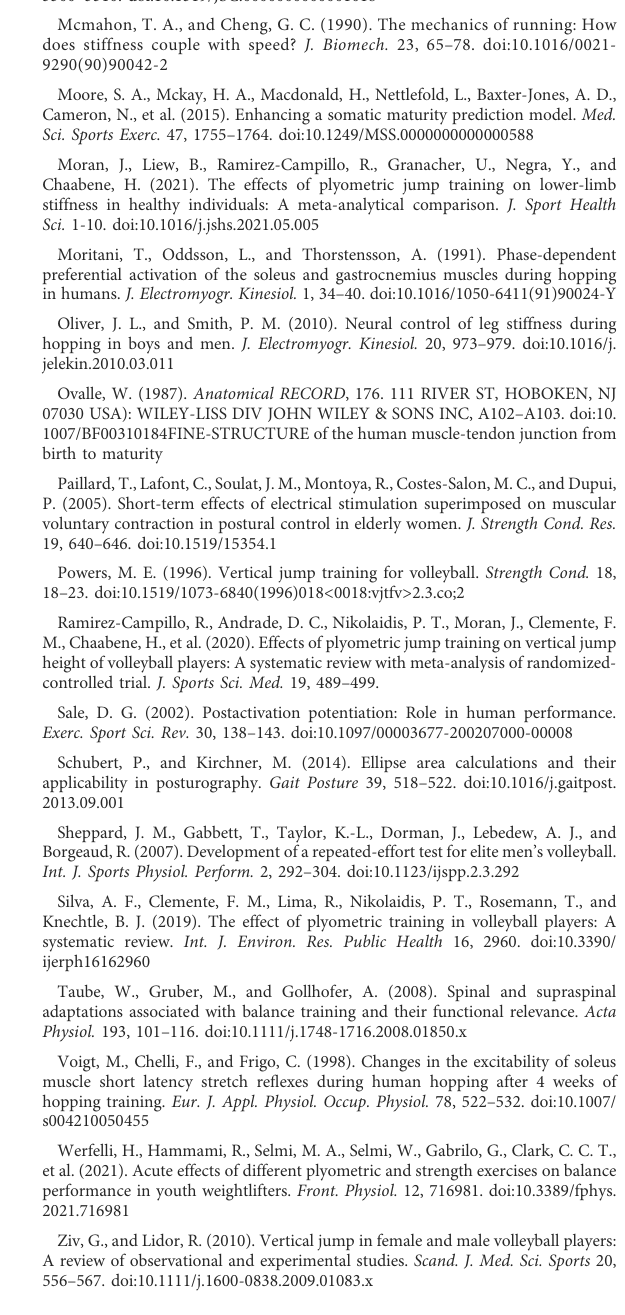
drop jump: The effect of maximal muscle strength. J. Strength Cond. Res. 29, 3300 – 3310.